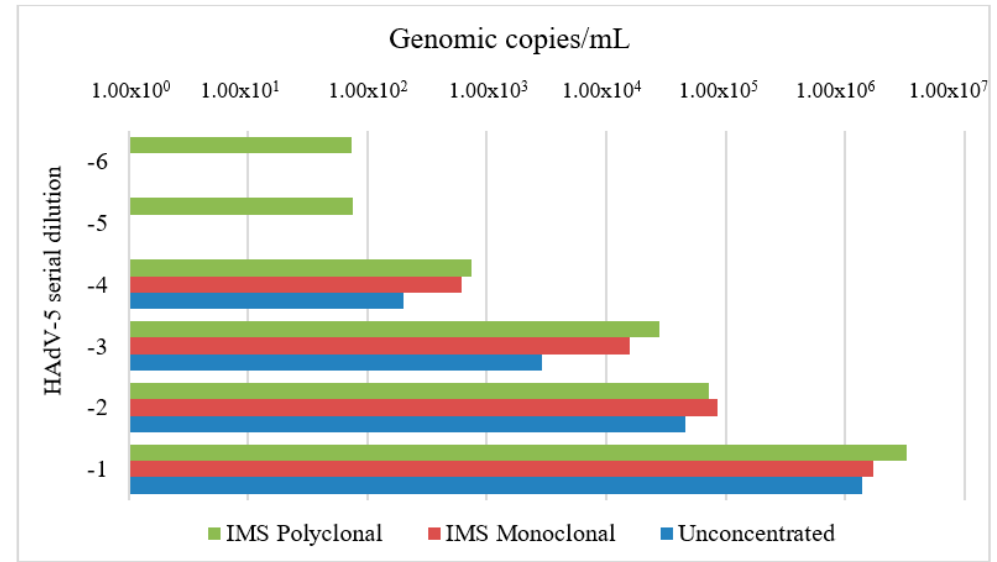
Figure 4. Averages of qPCR results to standard HAdV analyses of unconcentrated and concentrated samples by the IMS method.